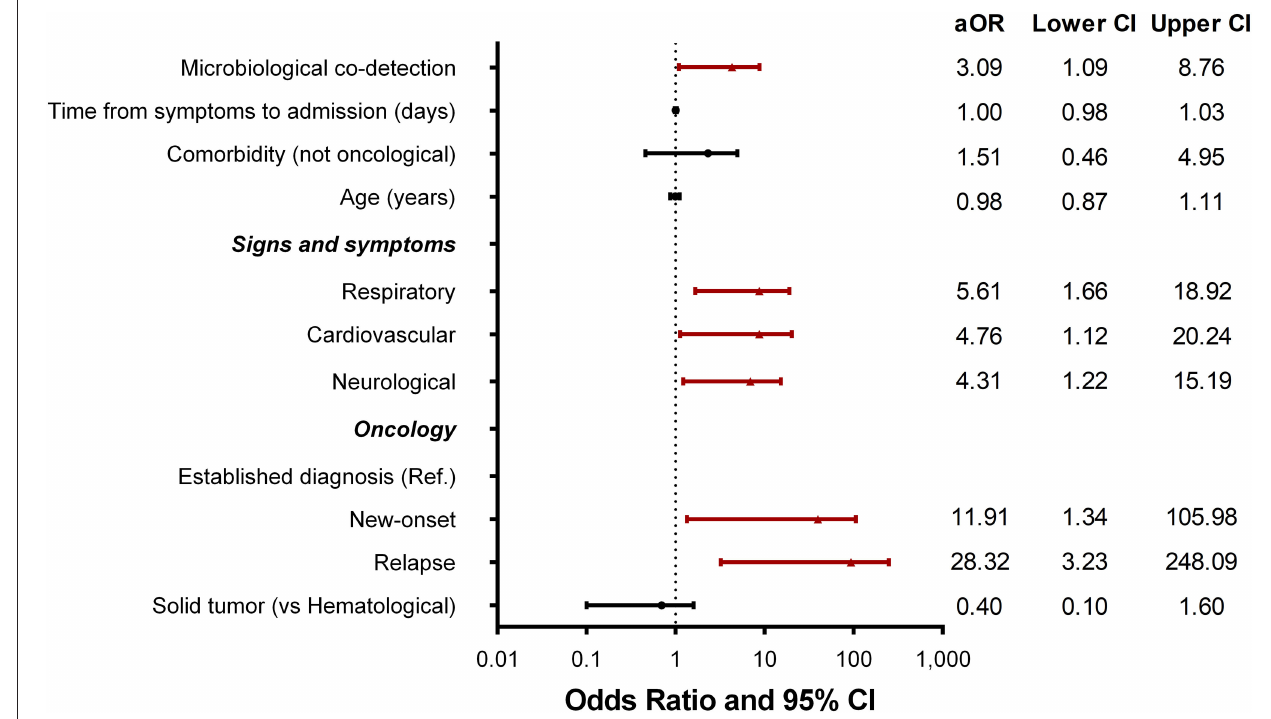
FIGURE 1 | Forest plot for odds–ratio and 95% confidence intervals from multivariate logistic regression model.